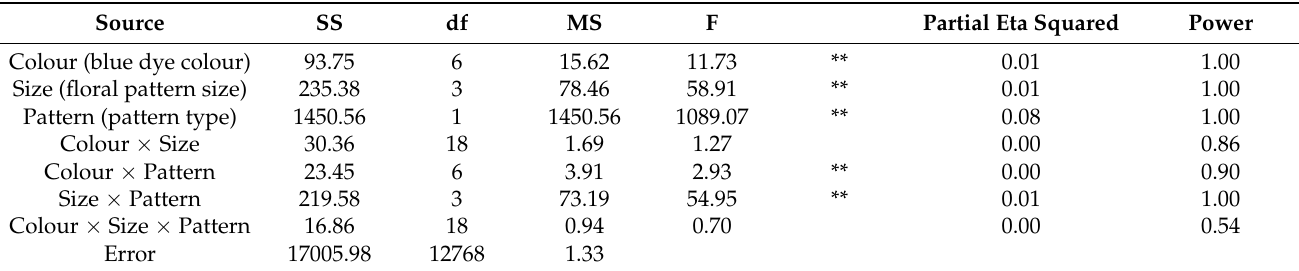
Table 3. ANOVA of blue dye colours, floral pattern sizes and pattern